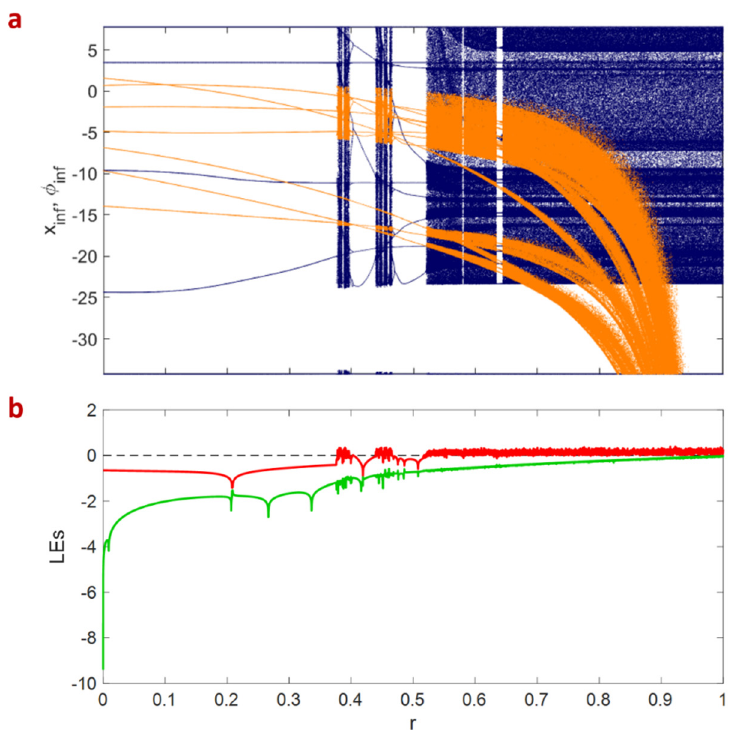
Figure 3. ( a ) The bifurcation diagram (navy blue and orange colors refer to the x and ϕ variables) and ( b ) the Lyapunov exponents’ diagram of the memristive map model by the variation of r with considering k 1 = 0.03, k 2 = 0.15, k 3 = k 4 = 0.00001, I = 1, vr 1 = − 55, vr 2 = − 3, vc 1 = − 59, 𝑣𝑐 (cid:2870) = (cid:3398)3 , 𝑣 (cid:3047)(cid:3035) = (cid:3398)30 , 𝑣 (cid:3047)(cid:3035) = (cid:3398)20 , 𝑣 (cid:3045)(cid:3032)(cid:3046)(cid:3047) = (cid:3398)75 , 𝑣 (cid:3046) = 0 , 𝜃 = (cid:3398)40 , 𝜇 = 0.225 , and 𝜀 = 0.2 . The initial condition is ( x ( 1 ) , ϕ ( 1 )) = ( 0,0 ) . The neuron has periodic behavior for 0 ≤ r < 0.3783; however, by increasing the 𝑟 parameter, the most significant behavior of the neuron is chaotic bursting.